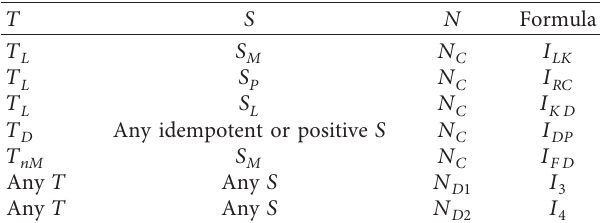
Table 6: Basic QL ′ -implications.